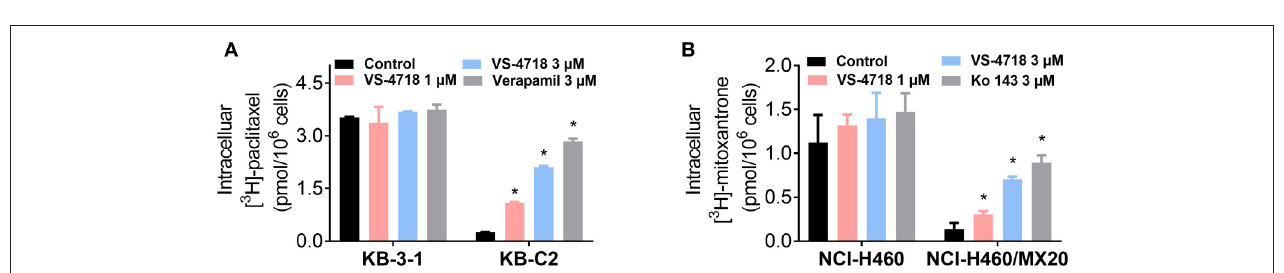
FIGURE 3 | The effect of VS-4718 on the protein expression and subcellular localization of ABCB1 and ABCG2 transporters. (A) Detection of ABCB1 expression in KB-C2 cells incubated with 3 µ M of VS-4718 for 0, 24, 48 and 72h. (B) Detection and relative intensity of ABCB1 expression in SW620/Ad300 cells incubated with 3 µ M of VS-4718 for 0, 24, 48, and 72h. (C) Detection of ABCG2 expression in NCI-H460/MX20 cells incubated with 3 µ M of VS-4718 for 0, 24, 48, and 72h. (D) Detection of ABCG2 expression in S1-M1-80 cells incubated with 3 µ M of VS-4718 for 0, 24, 48 and 72h. (E) Sub-cellular localization of ABCB1 expression in KB-C2 cells incubated with 3 µ M of VS-4718 for 0, 24, 48 and 72h. (F) Data are mean ± SD , representative of three independent experiments. Sub-cellular localization of ABCB1 expression in NCI-H460/MX20 cells incubated with 3 µ M of VS-4718 for 0, 24, 48, and 72h. Green: ABCB1 and ABCG2. Blue: DAPI counterstains the nuclei. KB-3-1 and NCI-H460 represented the control group; Scale bar: 200 µ M.